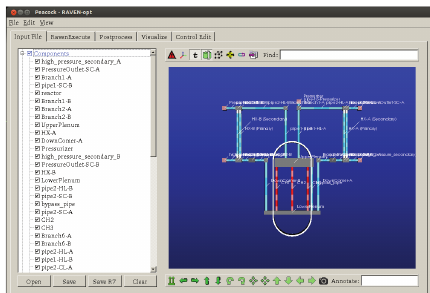
Figure5:ScreenshotofthePEACOCKGUIforaRAVEN/RELAP-7 input